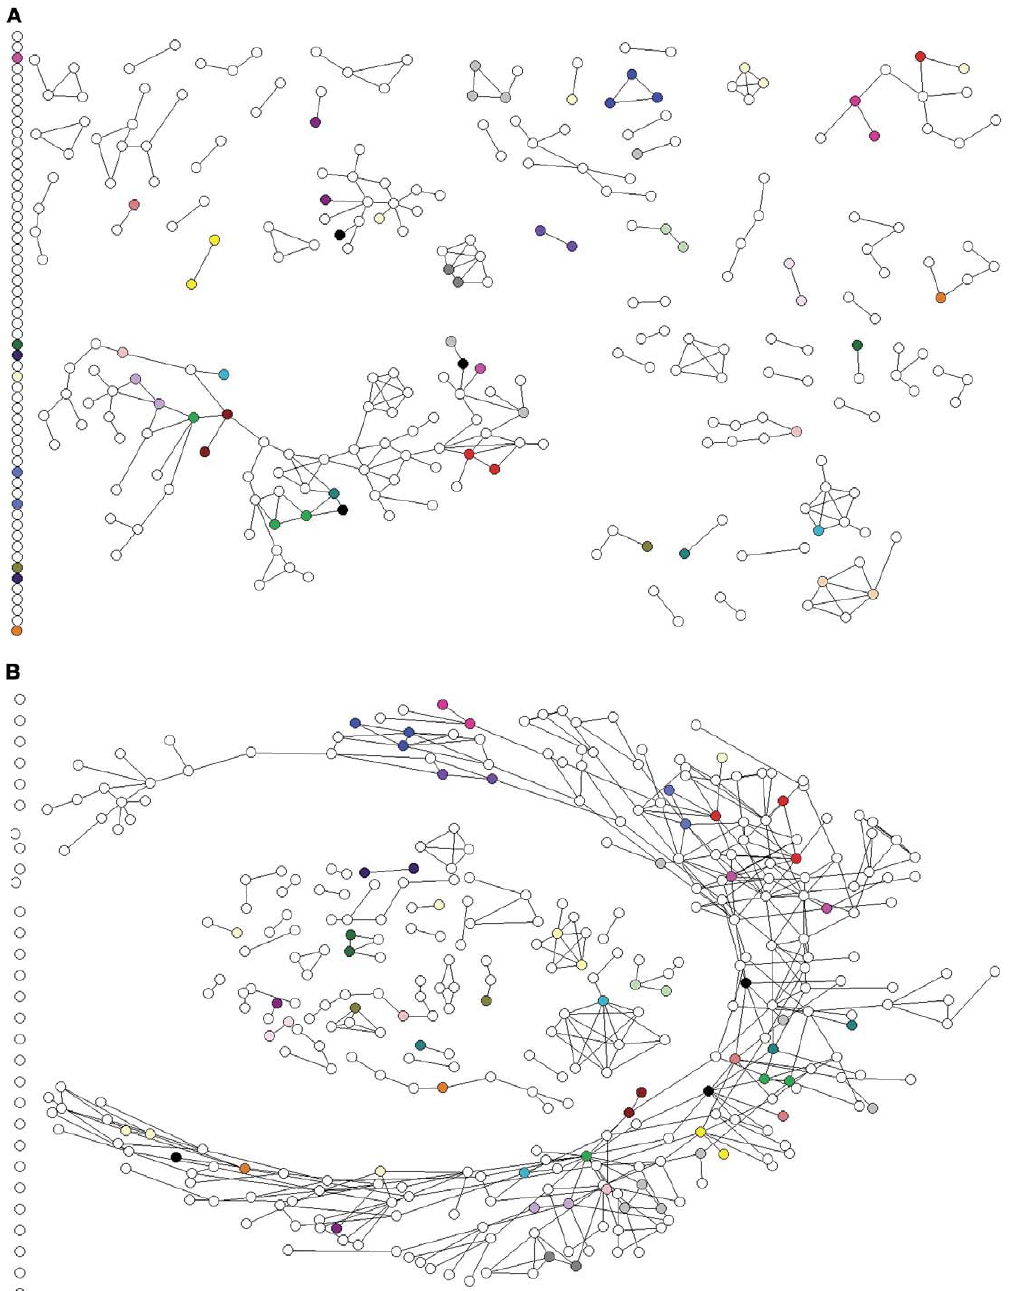
Figure 7. Network diagrams with phylogenetic clusters indicated by colour. Panel A. Baseline injecting network including all injecting ties reported in baseline interviews in main recruitment wave (July 2005–Feb 2006). Phylogenetic clusters identified using data from throughout the study period (July 2005–August 2008). Panel B. Flattened injecting network including all injecting ties reported throughout the study (July 2005– August 2008). Phylogenetic clusters identified using data from throughout the study period (July 2005–August